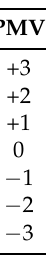
Table 1. Thermal sensation scale of PMV.